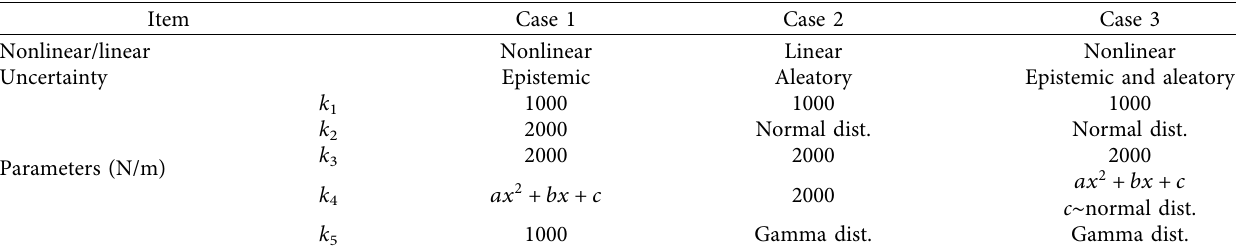
Figure 5: Nonlinear feature of the 3-DOF system: (a) spring stiffness k 4 and (b) FRF vary with excitation magnitude. Table 1: Comparison of the example